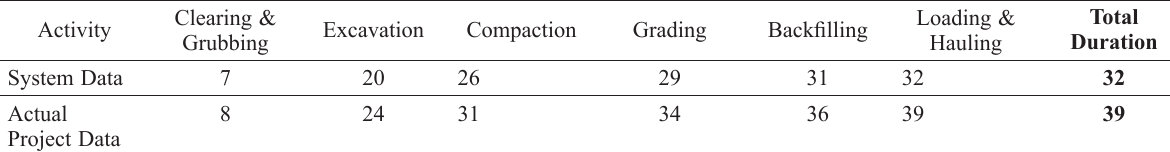
Table 4. Comparison of expected duration (days) results per earthmoving activity